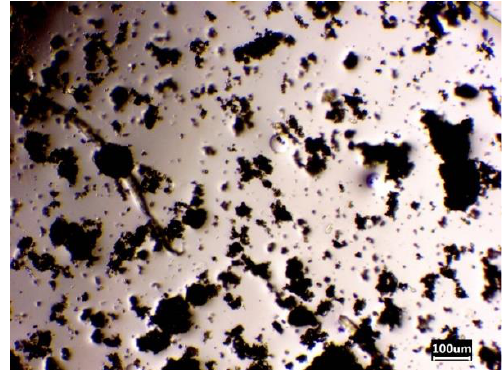
Figure 9. Micrograph of a magnetic sorbent film.